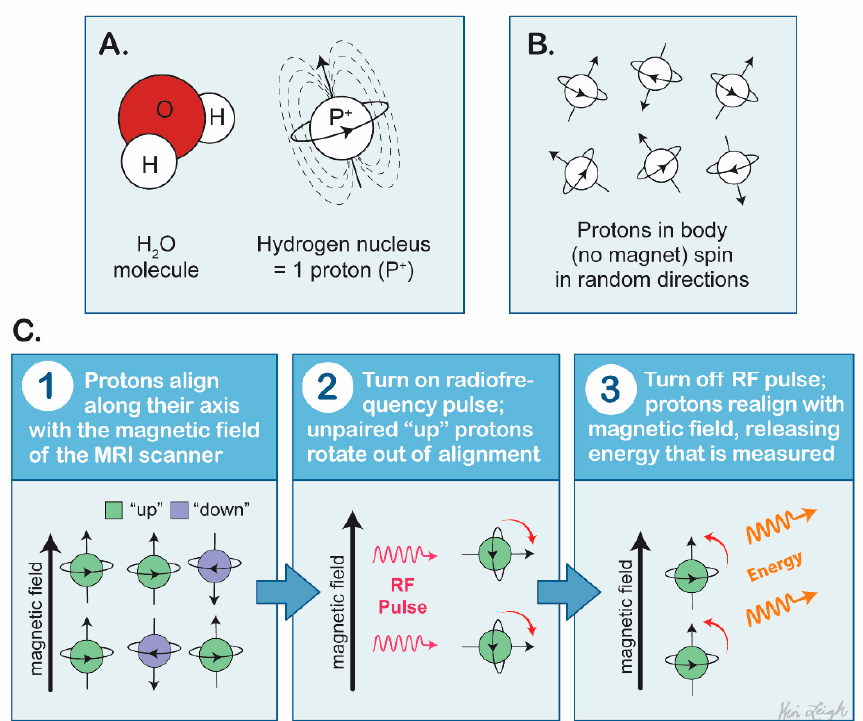
Figure 2. Mechanism of magnetic resonance imaging. ( A ) Hydrogen atoms are dispersed within the patient’s tissue with intrinsic spin. ( B ) Hydrogen atoms are spinning in random direction without alignment with one another. ( C ) Protons align with the magnetic field in parallel fashion; after the application of a radiofrequency pulse, the protons realign with the magnetic field, releasing energy and generating a high-resolution image of the tissue.